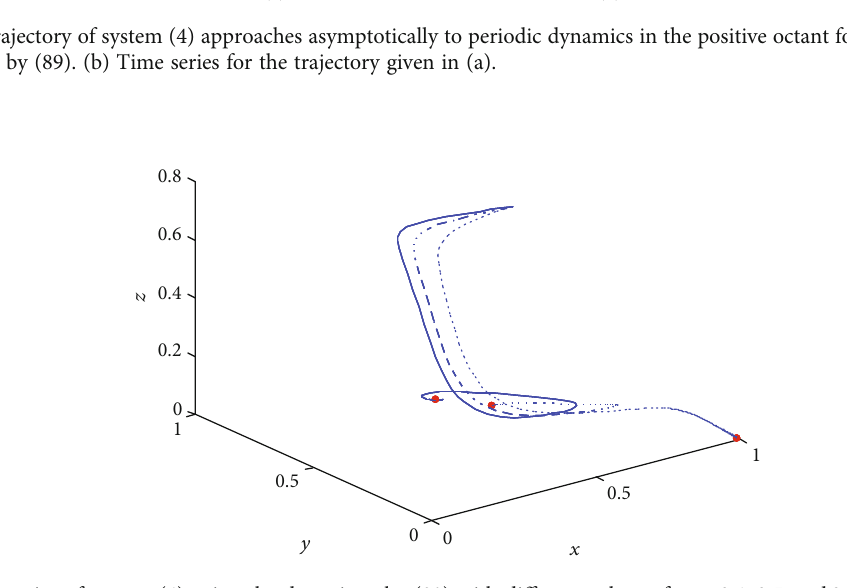
Figure 5: The trajectories of system (4) using the data given by (89) with di ff erent values of α dotted line, dashed line, and solid line,